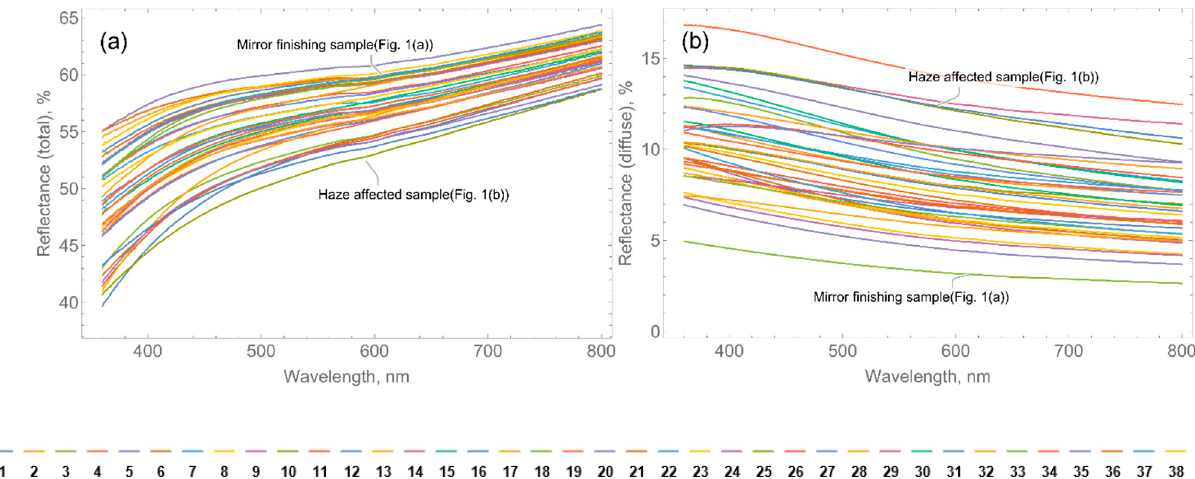
Figure 4. Optical reflection spectra for the AISI 430 ferritic stainless steel samples, measured with an integrating sphere at total reflection configuration ( a ), and diffuse reflection configuration ( b ). The spectra of the samples shown in Figure 1 are marked in the figures for the sake of comparison. A legend indicating the color of lines representing the various samples is given below.